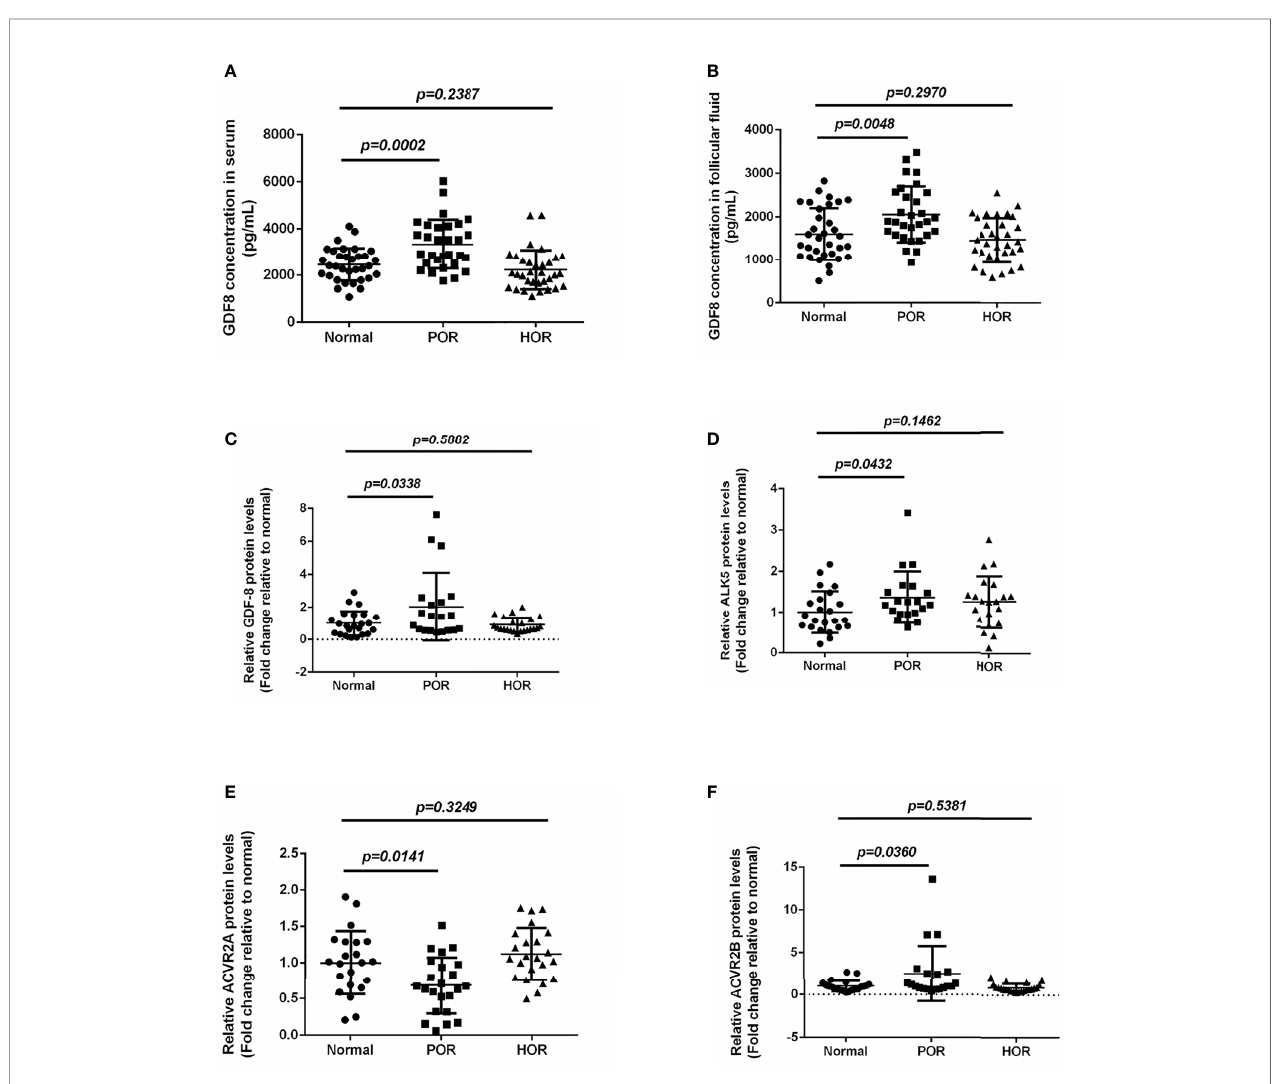
FIGURE 1 | The expression changes of GDF-8 and its responsible receptors in different ovarian response patients. (A, B) The accumulation level changes of GDF-8 in serum and follicular fl uid obtained from different ovarian response patients were determined by ELISA. (C – F) The protein expression level changes of GDF-8 and its responsible receptors (ALK5, ACVR2A, and ACVR2B) were examined in different ovarian response patient granulosa cells using western blot. The data were analyzed by the two-sample t test assuming unequal variances. P < 0.05 was considered statistically signi fi cant. POR (n=30), poor ovarian response. HOR (n=33), hyper ovarian response. Normal,